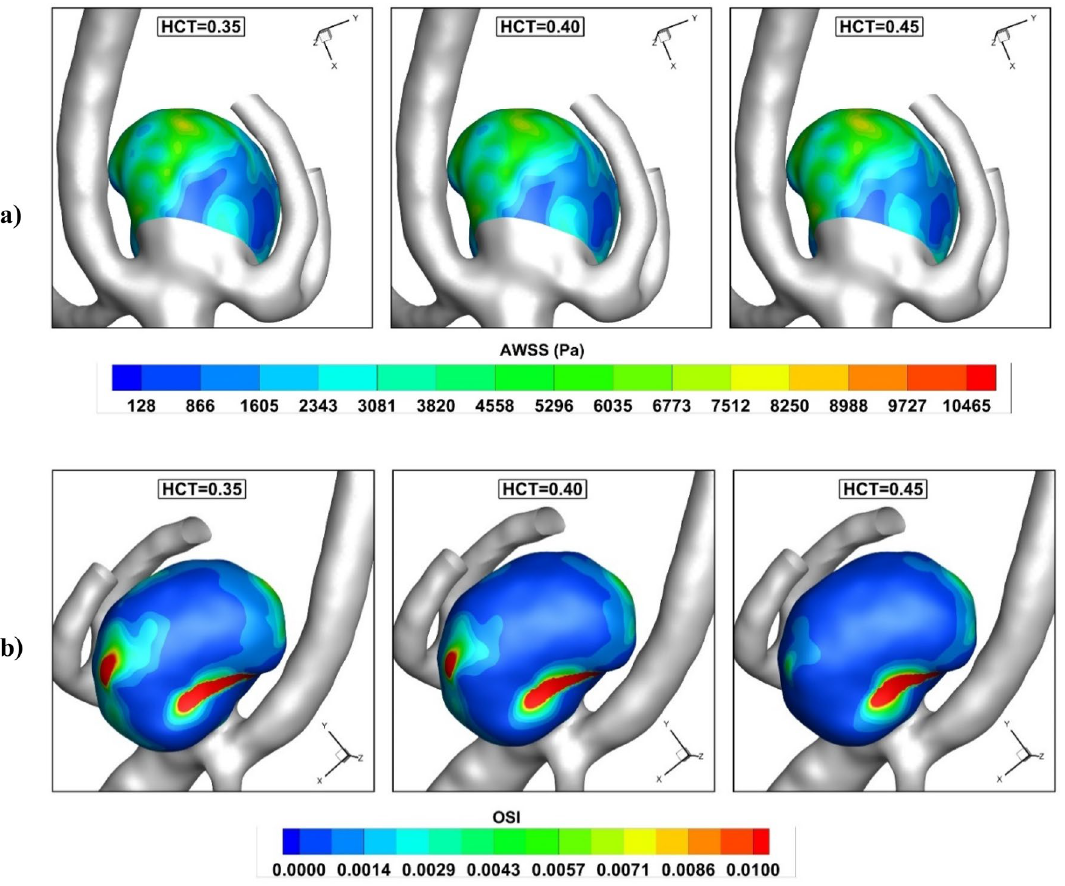
Figure 9. Influence of HCT on ( a ) pressure ( b ) AWSS ( c ) iso-velocity (v = 0.75 m/s) contour at early